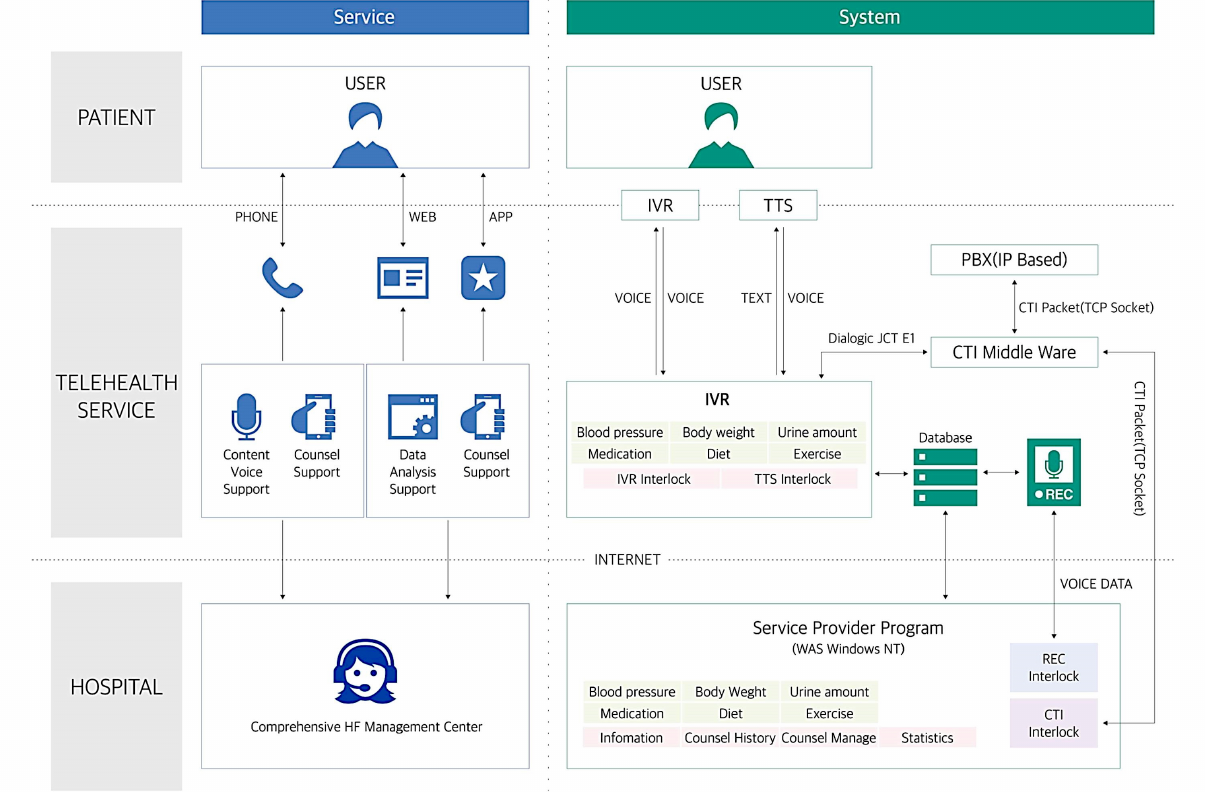
Figure 2. Schematic diagram of the ICT-based telehealth program in HF. ICT: information communication technology, HF: heart failure, TTS: text to speech, IVR: interactive voice response, PBX: private branch exchange, CTI: computer telephony integration, TCP: transmission control protocol, WAS: Web application server, REC: recording, IP: Internet